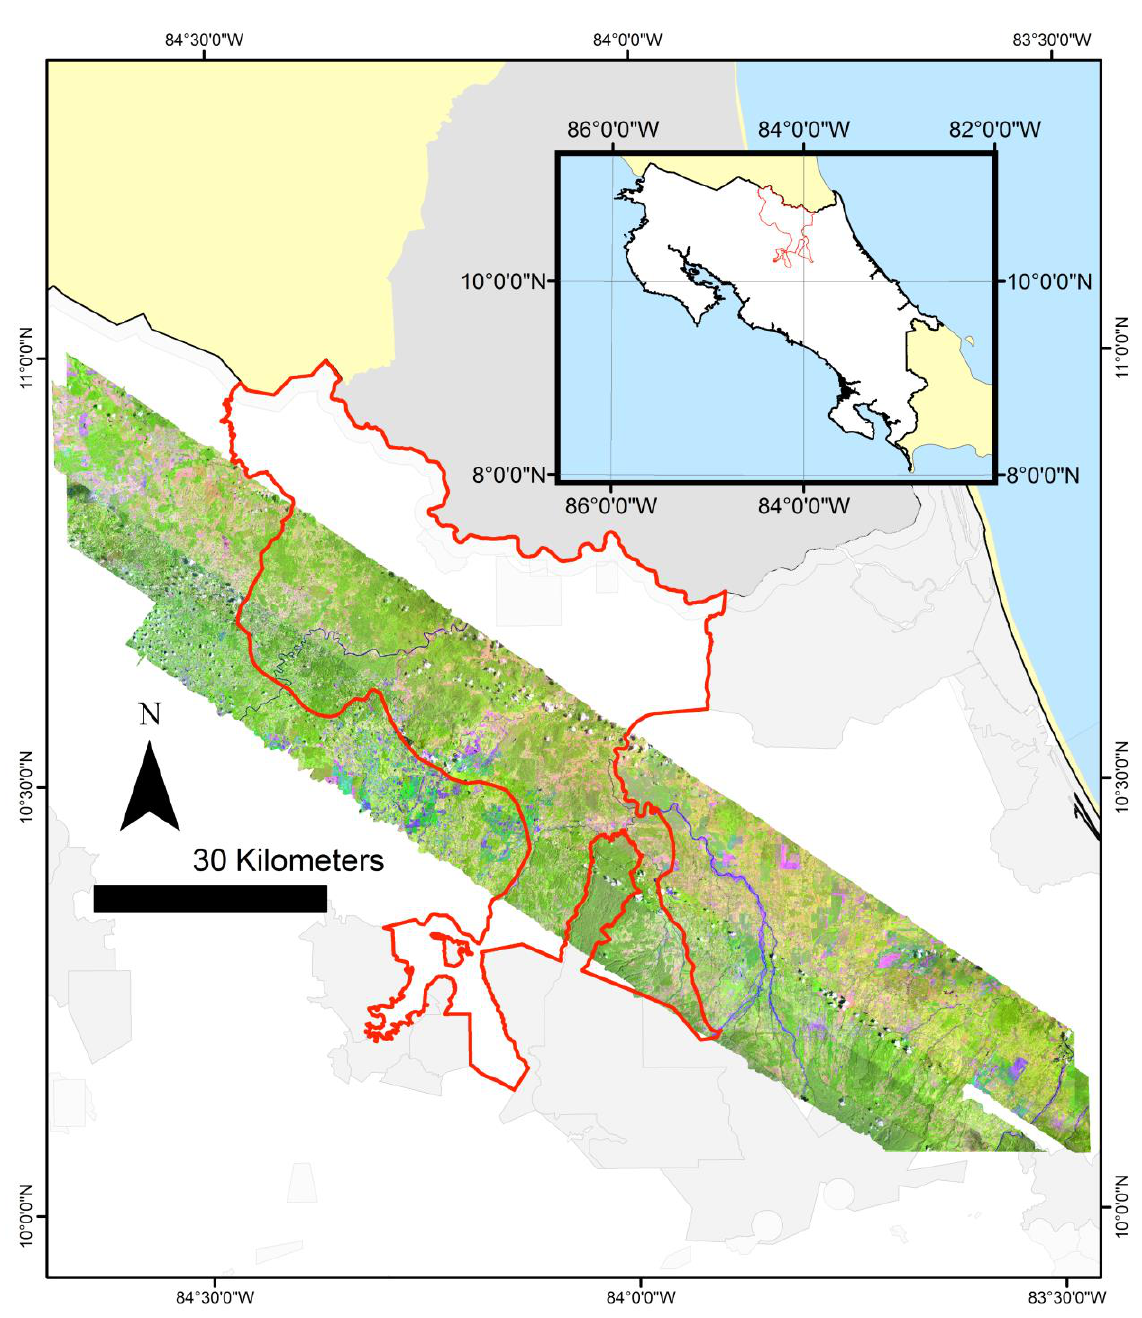
Figure 1. Map of the study area in lowland Costa Rica (10.42′N–84.00′E), showing the San Juan-La Selva Biological Corridor (red line, 2466 km 2 ), the hyperspectral imagery mosaic, and parks and wildlife refuges (shades of grey). La Selva Biological Station is centrally located in the imagery (a 4509 km 2